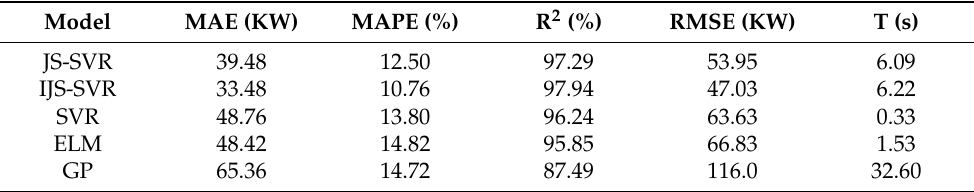
Table 5. Evaluation index values of each prediction model in